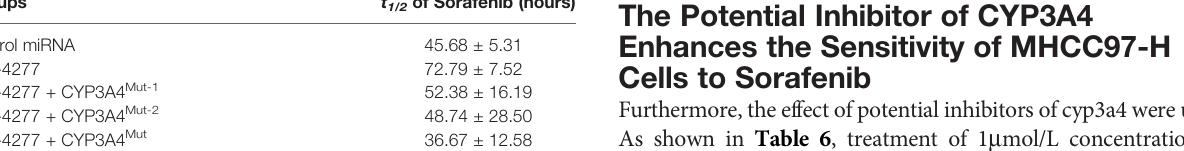
TABLE 4 | Effect of miR-4277 on the clearance of sorafenib in the subcutaneous tumors formed by MHCC97-H cells.